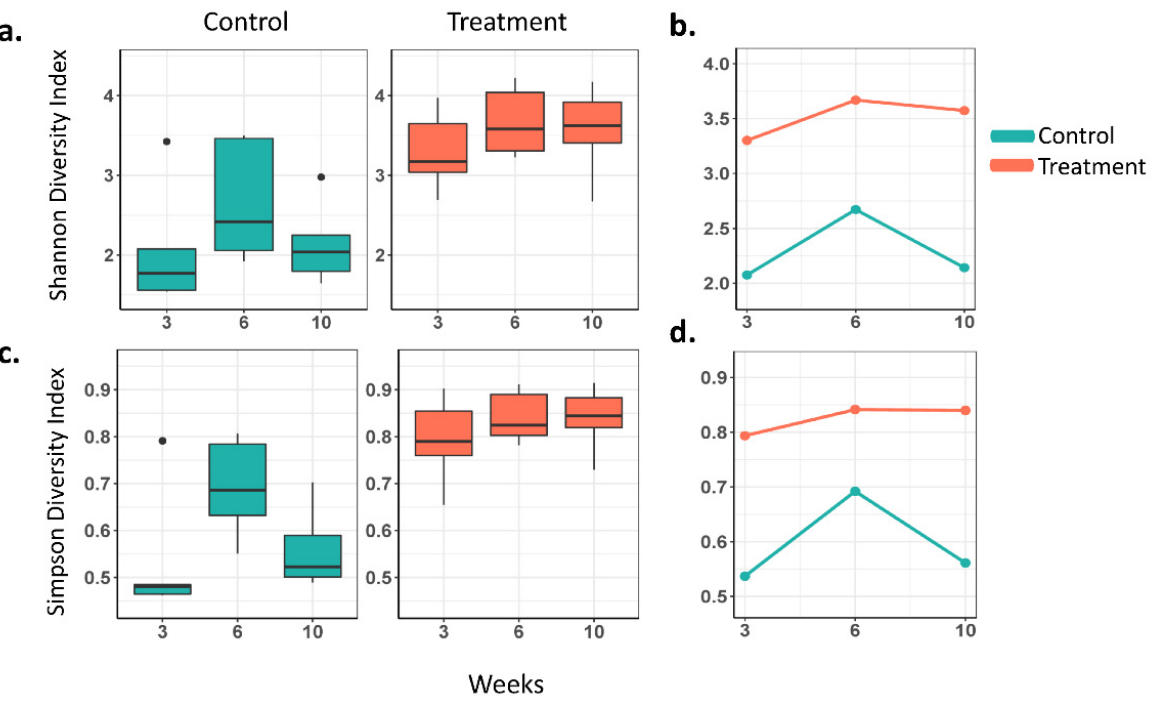
Figure 2. Distribution of Shannon and Simpson diversity indices in the GI microbiota dysbiosis ( n = 6) and Control ( n = 5) groups. ( a ) Boxplot showing the Shannon diversity index at 3, 6, and 10 weeks, ( b ) mean Shannon index over time by group, ( c ) boxplot showing the Simpson diversity index at 3, 6, and 10 weeks, and ( d ) mean Simpson index over time by groups.